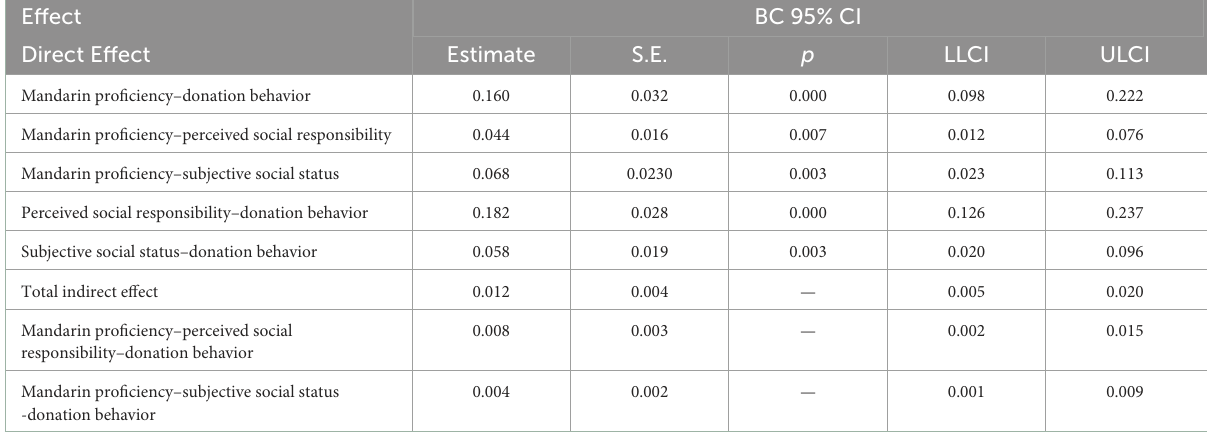
TABLE 5 The influencing mechanism of Mandarin proficiency on donation behavior ( N =